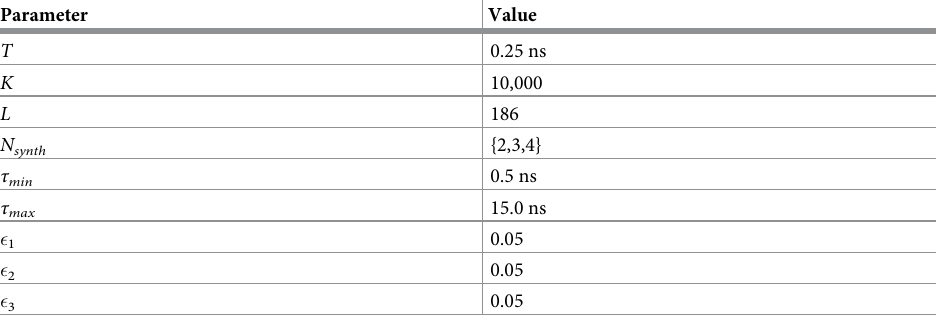
Table 1. Parameters of synthetic dataset and BDE implementation during the synthetic